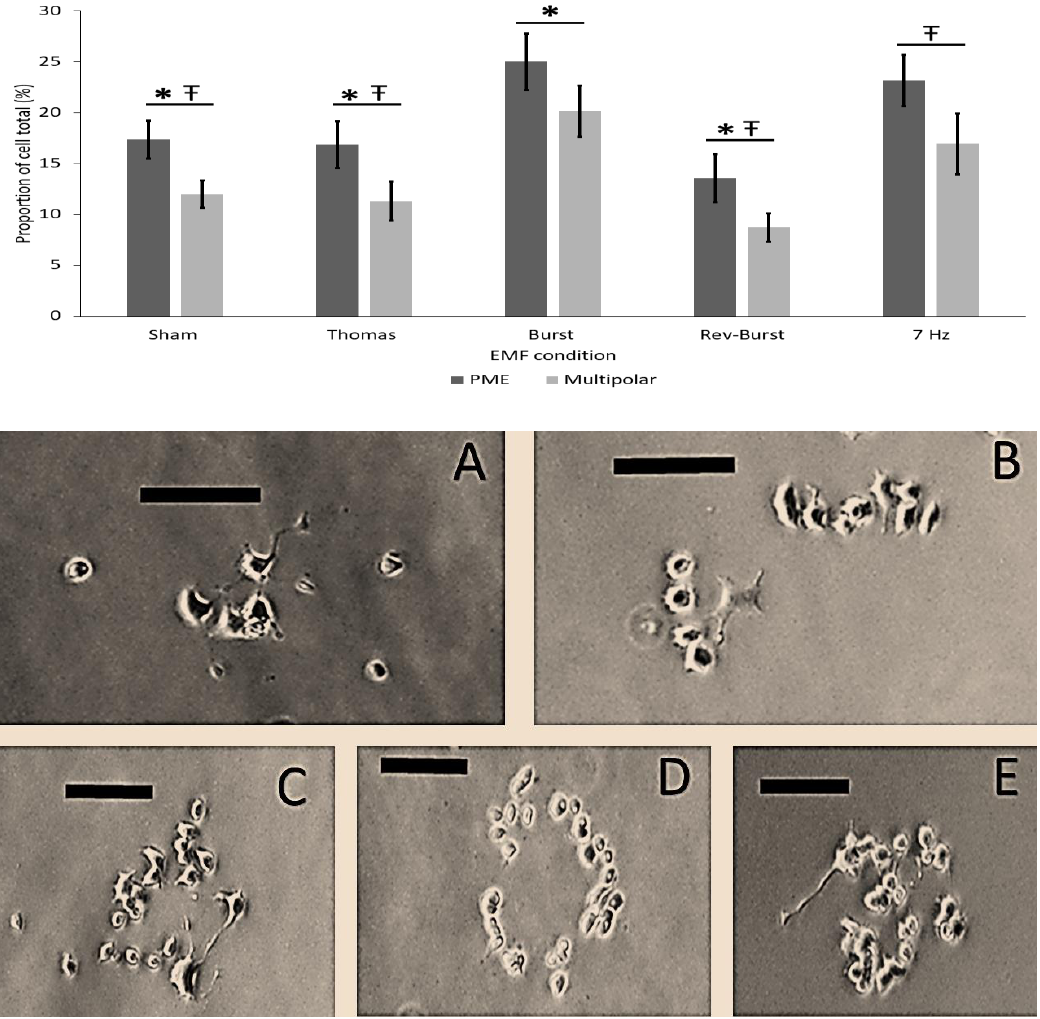
Figure 5. The graph (upper panel) shows differences in morphology between PC12 cells treated with 0.5 µM forskolin